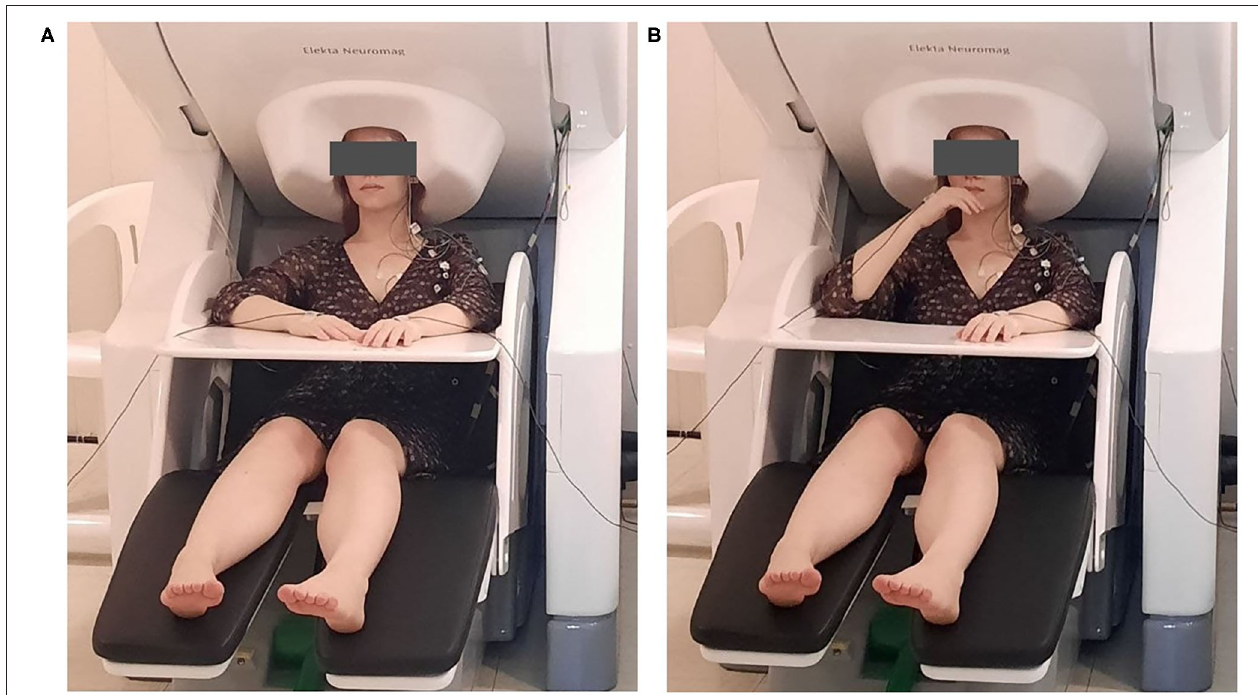
FIGURE 1 | A patient performing a right elbow flexion task in the Elekta Neuromag system. The task of the patient was to bring their hand toward their mouth, imitating self-feeding, after the voice command of the experimenter. (A) Initial position. (B) Hand lifted to the